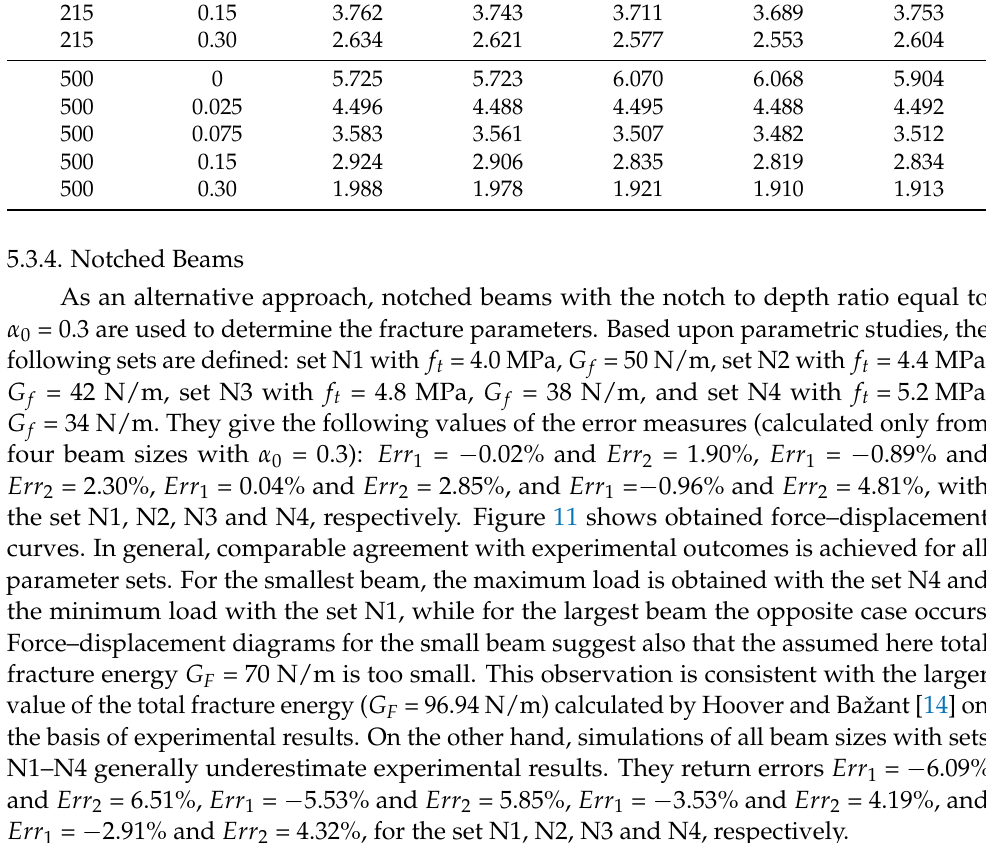
Table 3. Calculated nominal strengths σ FEM